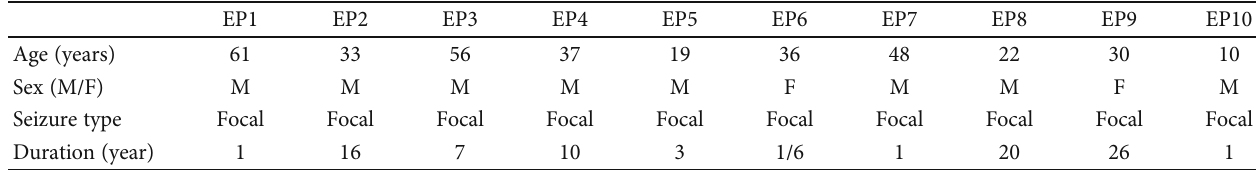
Table 1: The detailed information about the